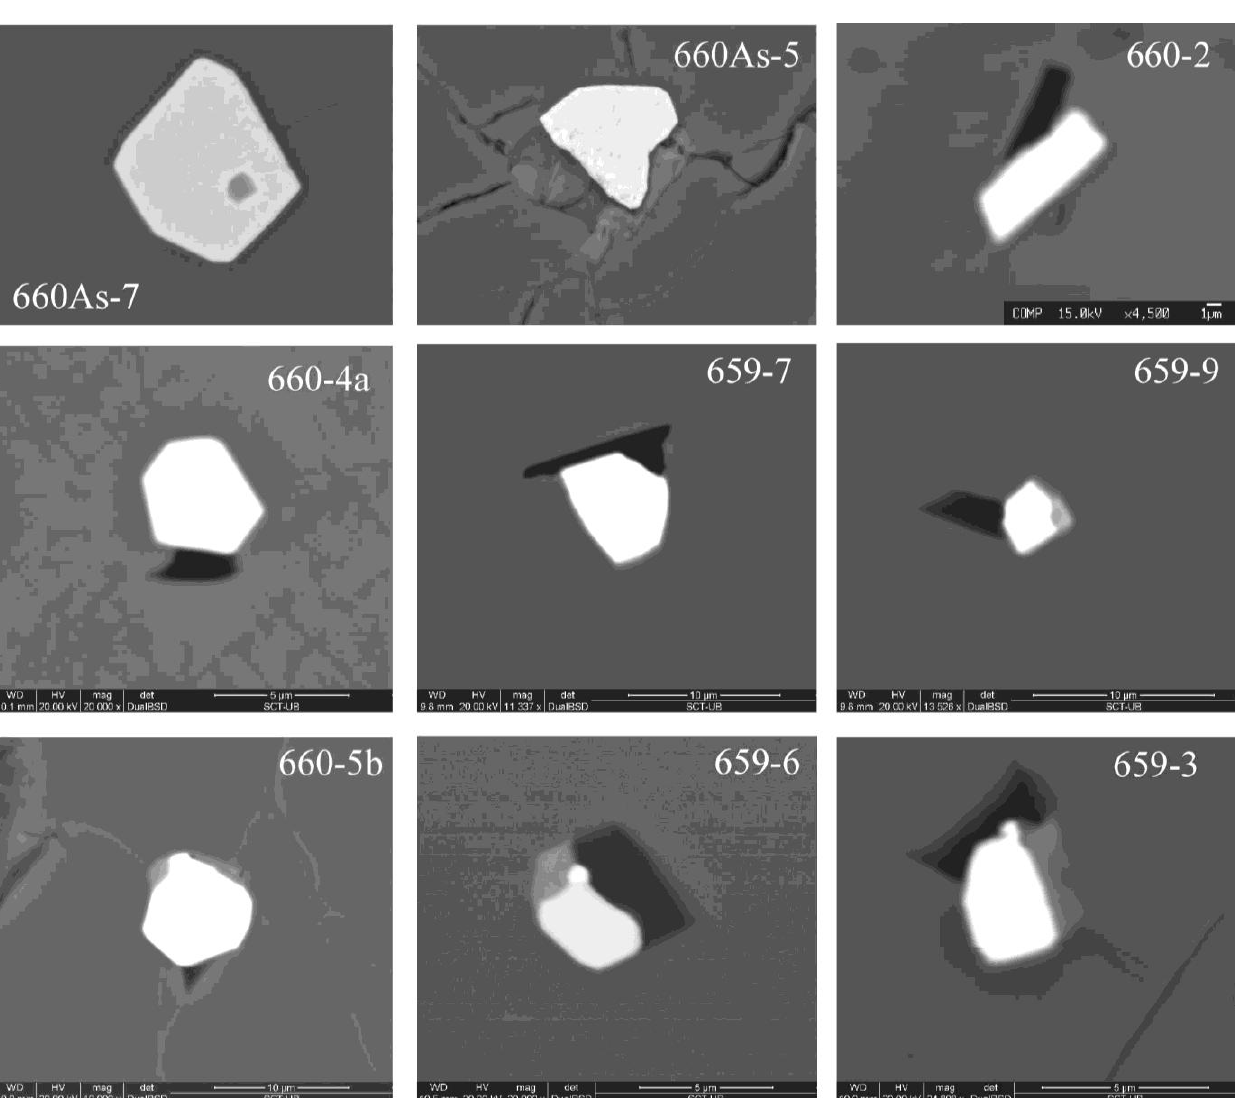
Figure 10. Paragenetic assemblages of Ru-Os-Ir PGM in the CHR-2 chromitite (BSE images). 660As-7: Euhedral grain of laurite with included pentlandite in chromite 2; 660As-5: Porous crystal of laurite + ferrianchromite located along crack in chromite 2; 660-2: Sub-euhedral erlichmanite + kaolinite included in chromite 2; 660-4a: Euhedral laurite + serpentine included in chromite; 659-7: Composite inclusion of laurite + phlogopite in chromite 1; 659-9: Composite inclusion of sub-euhedral erlichmanite + Ni-sulfide + amphibole in chromite 1; 660-5b: Sub-euhedral laurite + Fe-oxide + serpentine included in chromite 2; 659-6: Composite inclusion of laurite + Ir-sulfide + millerite + serpentine in chromite 2; 659-3: Composite inclusion of laurite + hematite + serpentine in chromite